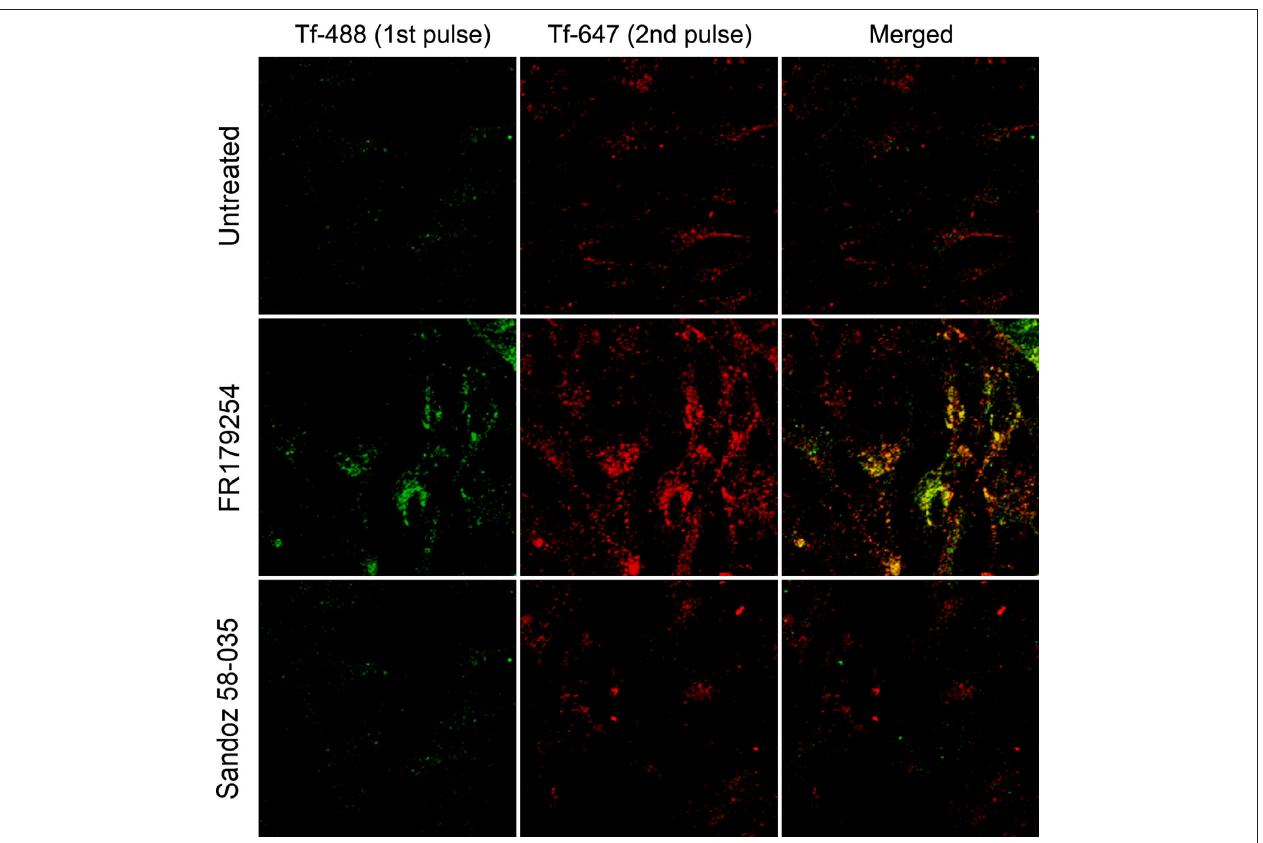
Figure 5 | Successive waves of internalized transferrin are delayed by Fr179254 treatment. Cells were treated as indicated and pulse-chased with Tf-488. At 30 ′ chase, cells were subsequently pulsed with Tf-647. After a total of